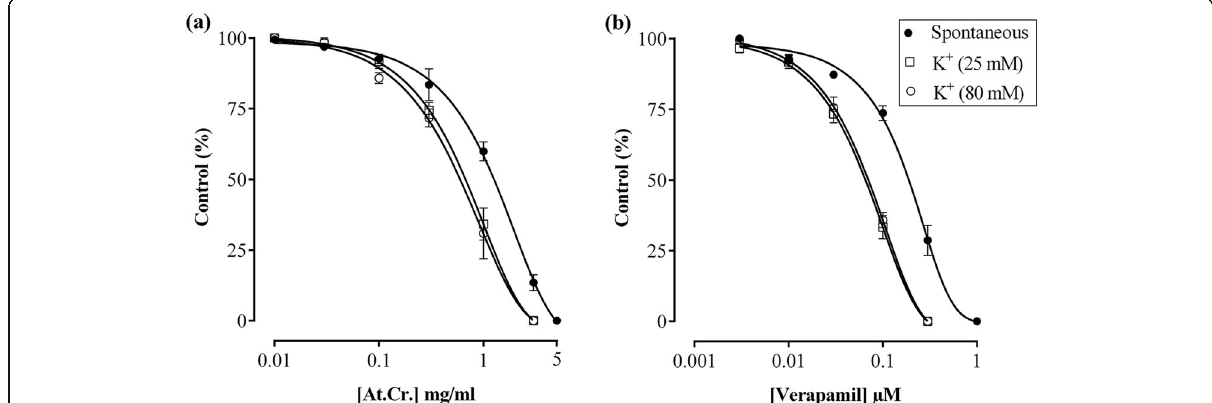
Fig. 4 Inhibitory effects of ( a ) Asphodelus tenuifolius crude extract (At.Cr) and ( b ) verapamil against spontaneous, K + (25 mM) and K + (80 mM) induced contractions in jejunum preparations. Values are mean ± SEM ( n =